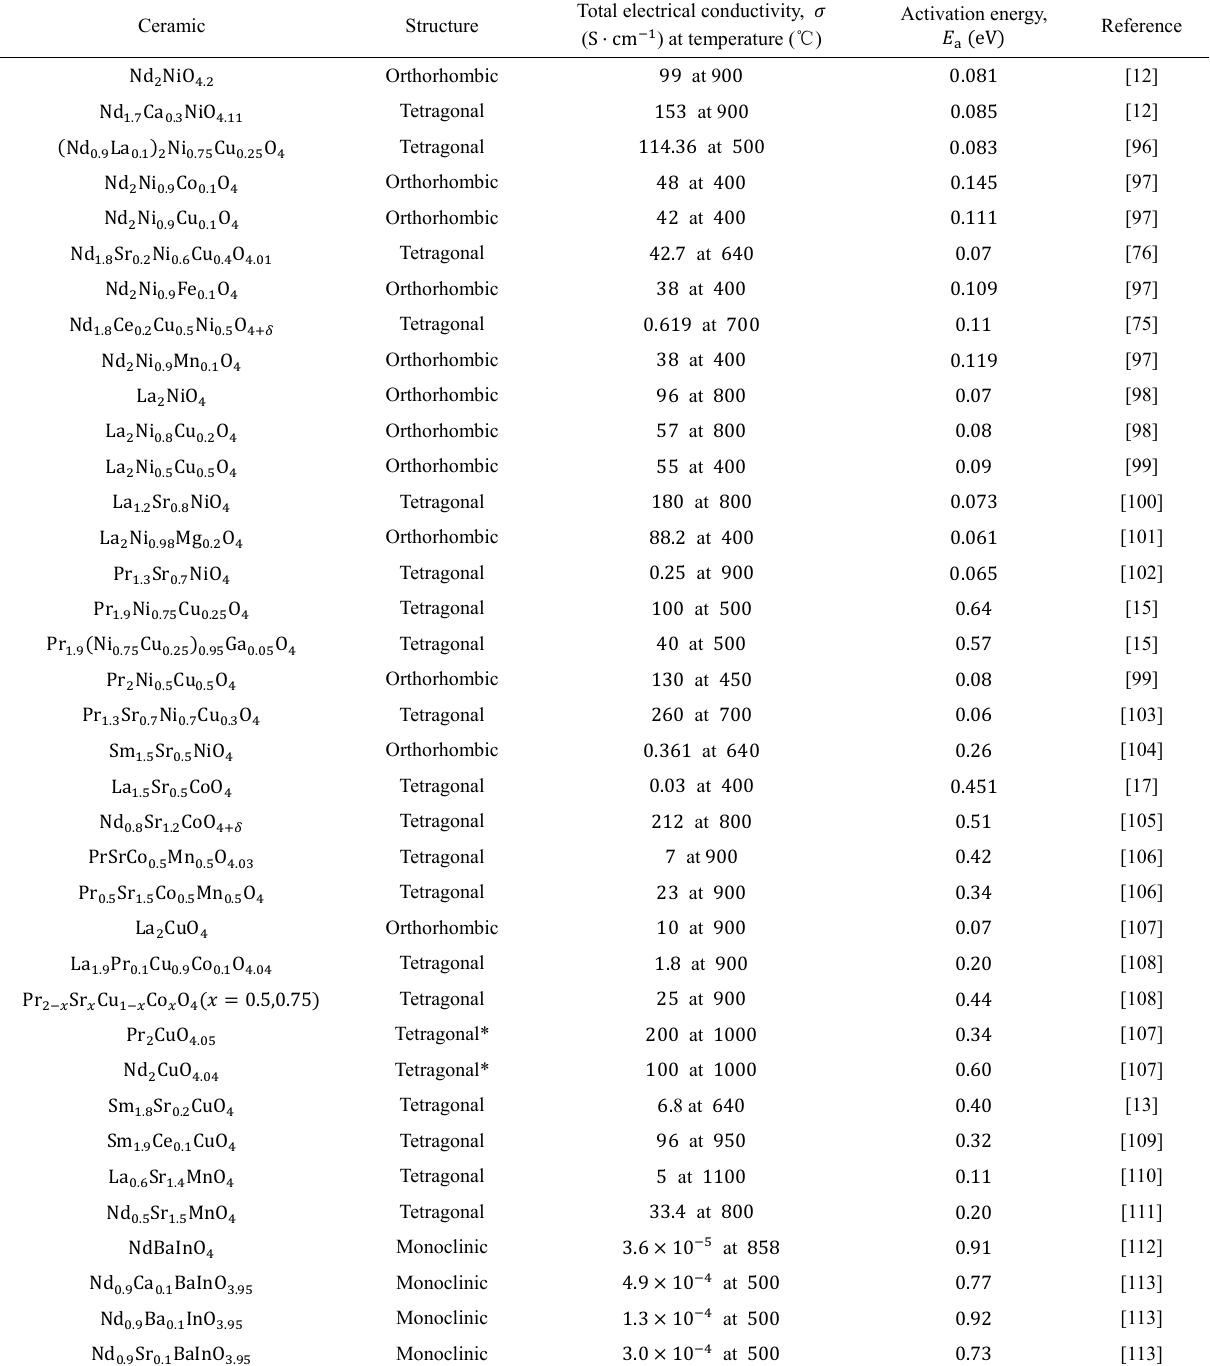
Table 1 Structure, highest experimentally measured electrical conductivity, and activation energy of recently studied ceramics